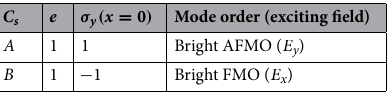
Table 4. IRREPs of group C s , mode order and exciting E ext